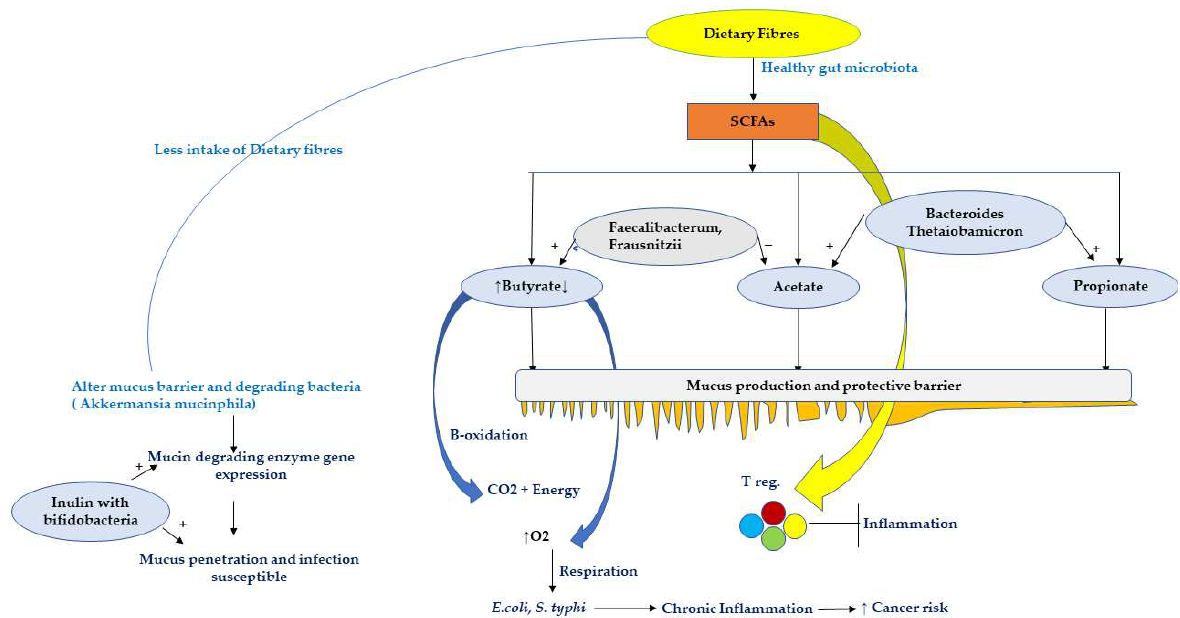
Figure 1. The key role of high and low dietary fibres on gut microbiota, diversity, and function on host health: action of dietary fibres on the progression of colon cancer takes place, high intake of dietary fibres will change into SCFAs, such as propionate, butyrate, and acetate, under the action of healthy gut microbiota as well as inhibit TNF, NB-kF, and early colonic lesion and regulate microbiota health. Moreover, due to intake of low dietary fibres, the gut microbiota is altered, resulting in colonic lesion due to a disturbance in mucus-degrading enzymes and bacteria [64]. ↓ ; decreasing, ↑ : increasing.